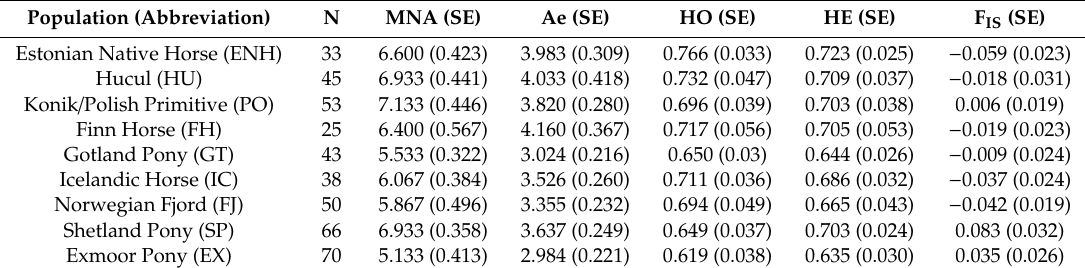
Table 1. Genetic diversity within 9 Northern Pony breeds (see Figure S1, clade III) based on 15 short tandem repeats (STR)